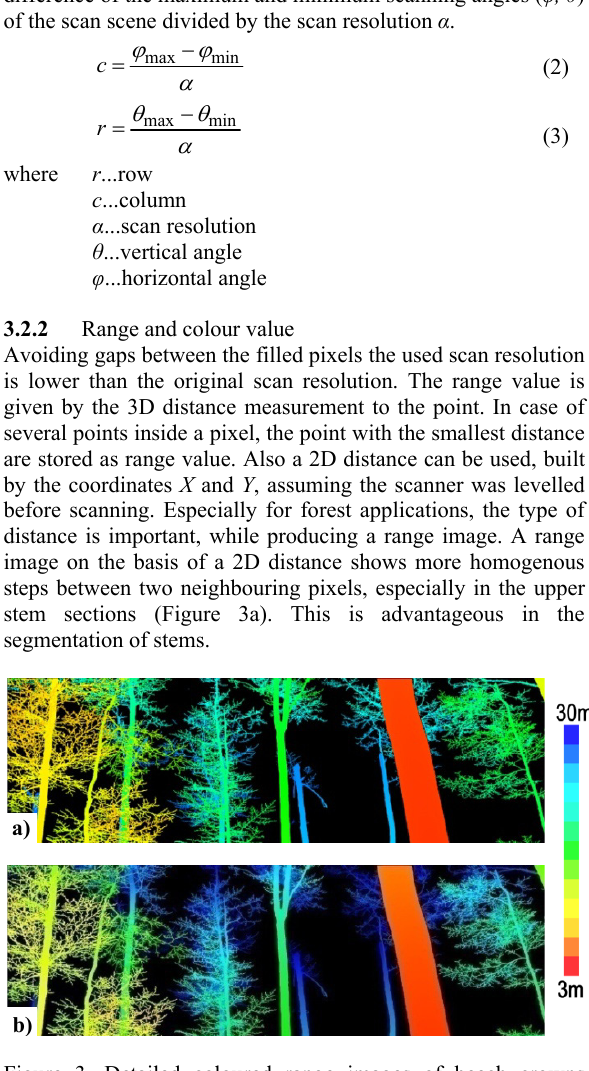
Figure 3. Detailed coloured range images of beech